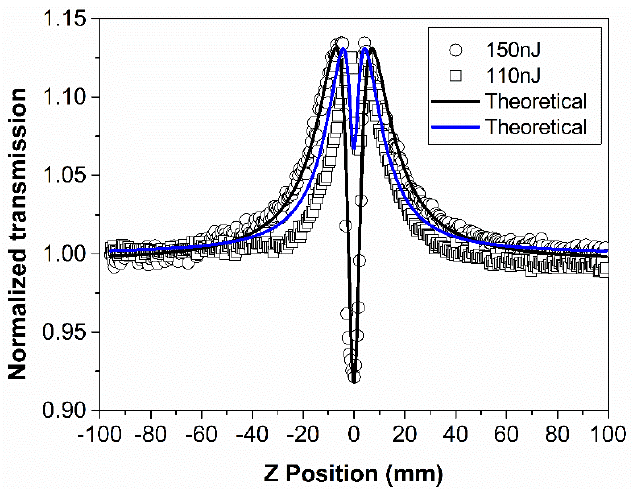
Figure 3. Double peak and a valley at relatively high laser energies (110 nJ and 150 nJ).